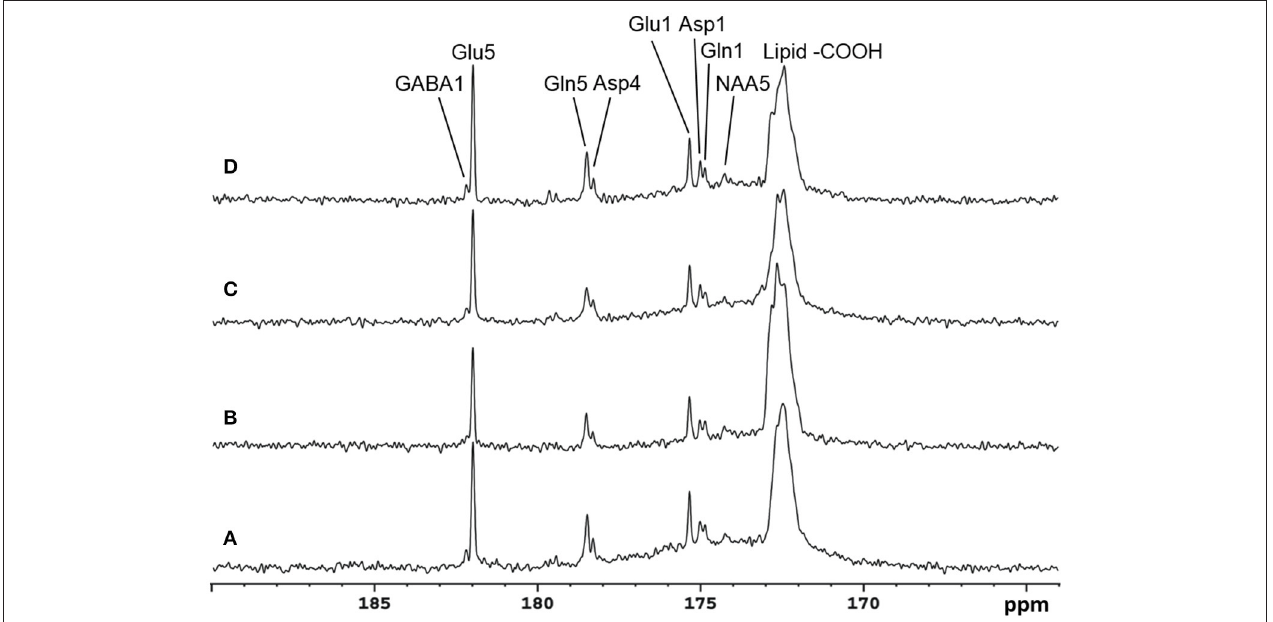
FIGURE 7 | Spectra obtained from four healthy volunteers with the same NOE and decoupling power settings at 7 Tesla. The upper three traces are summed from the last 17.4 min at the end of infusion with TR 5 S, NS 208. The bottom trace is accumulated from a different subject in the last 19.6 min of data acquisition with TR 6s, NS 192. In addition to Glu C5 and C1, Gln C5 and C1, and Asp C4 and C1, NAA C5(174.3 ppm) and GABA C1 were also clearly detected. Adapted from Li et al. [33].